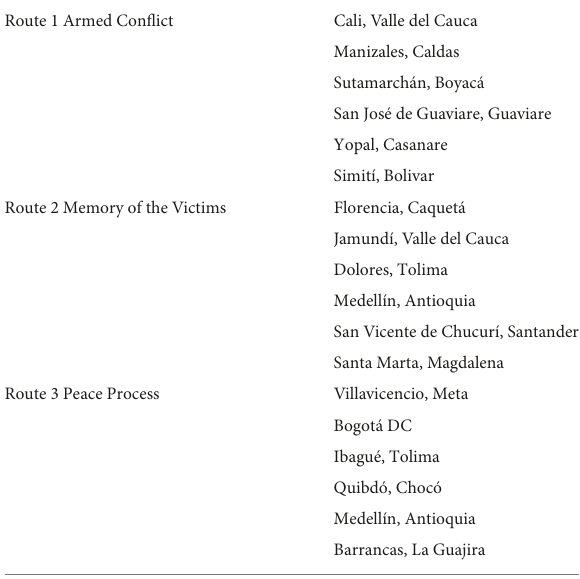
TABLE 2 Interaction routes and the municipalities making part of them: Armed Conflict, Memory of the Victims, and Peace Process. Route 1 Armed